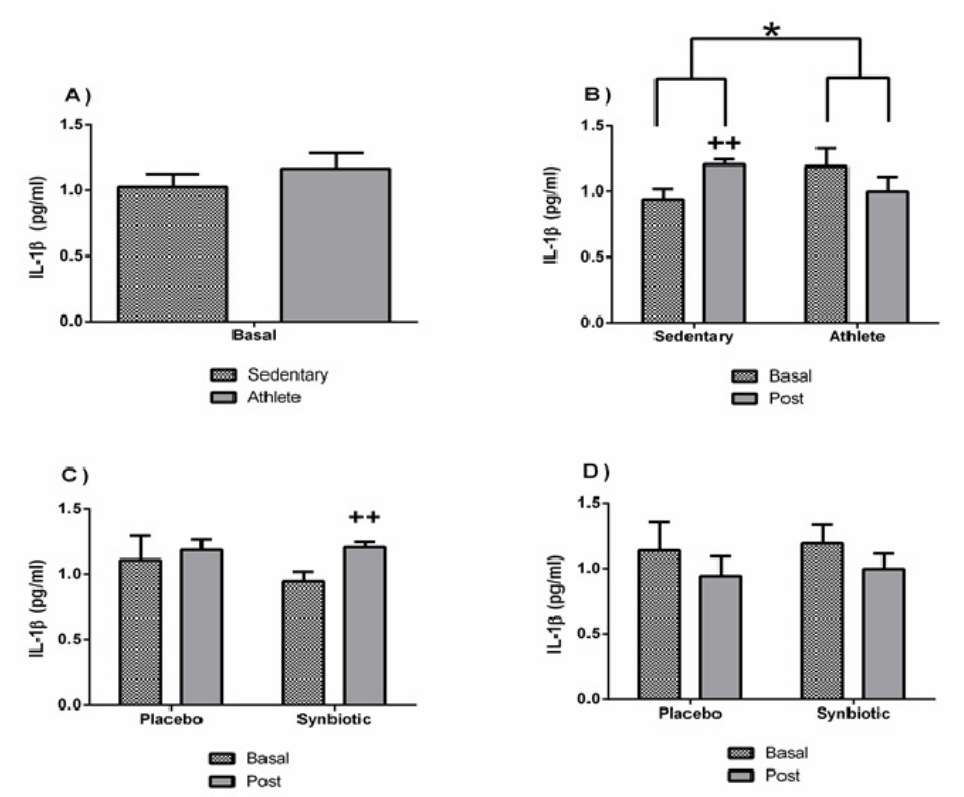
Figure 5. Effect of training and consumption of a synbiotic in this condition on the IL-1 β cytokine.